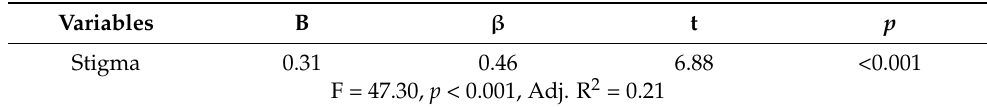
Table 4. Factors influencing anxiety ( n = 180).